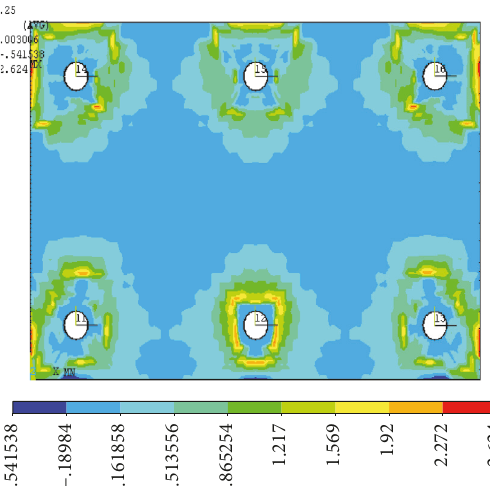
Figure 5: Principal tensile stress when the displacement resulting from the corrosion-induced expansion reaches 0.00513